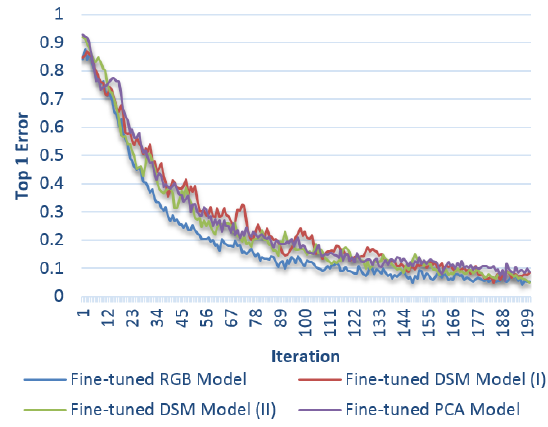
Figure 3. The rate of convergence of training on different models (I: DSM dataset trained by the ImageNet, II: DSM dataset trained by the fine-tuned RGB model) Also Figure 3 shows how the accuracy of training improves with more iterations. According to Table 1, the performance of training on the DSM dataset based on fine-tuned RGB model is better than others with the lowest top 1 error and higher accuracy (0.0486 and 95.1 %, respectively). Moreover, when the fine-tuned RGB model is employed as the initial model for training on the DSM dataset, the top 1 error decrease about two times. Also, third strategy based on PCA does not show any significant improvement on learning accuracy. To have an accurate assessment on the training performance, the maximum scores of validation tiles in each class of roofs can be compared with other classes as Figure 4 for different models.